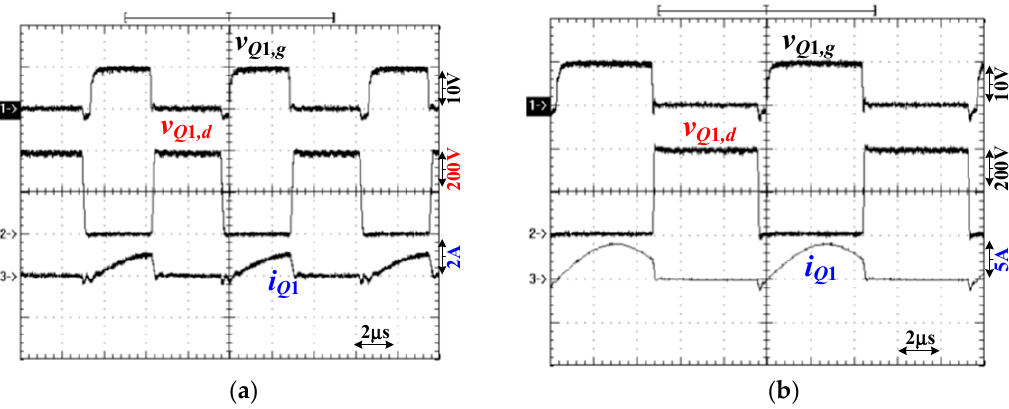
Figure 5. Test results of switch Q 1 under V 1 = 400 V with ( a ) 96 W (20%) output and ( b ) 480 W (100%) output.